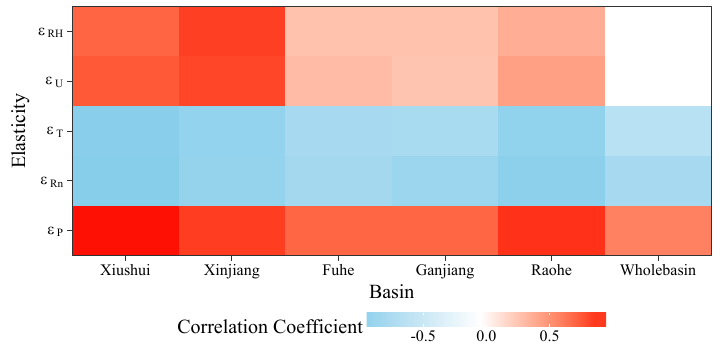
Figure 6. Correlation between the calibrated n and climate elasticities in PYLB, as well as the five sub-basins. Blank denotes no significant correlation between n and climate elasticities (at the 95% significance